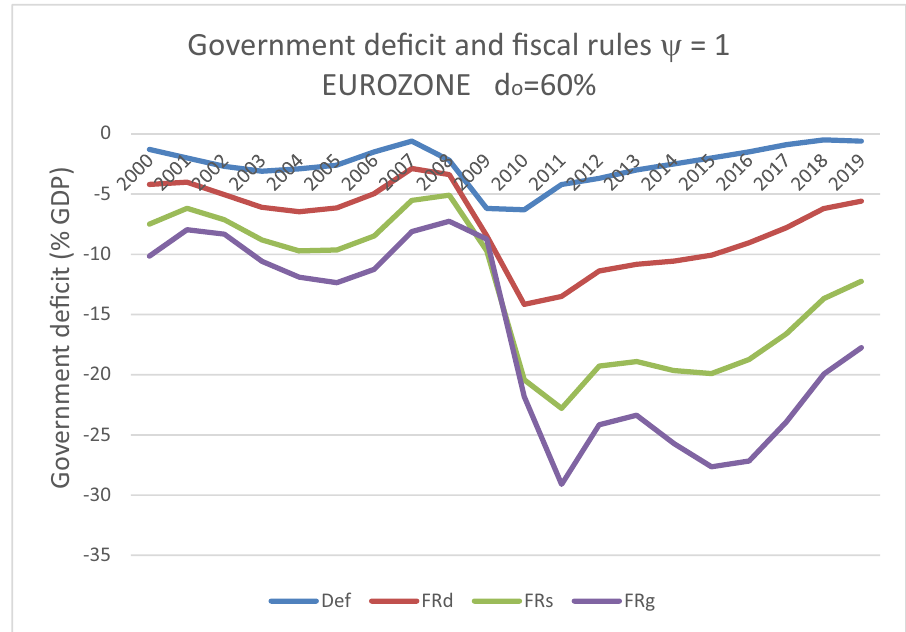
Figure 1.3: Eurozone countries government de fi cit ψ = 1 ( Source: Own elaboration from data on Table 1 ) .